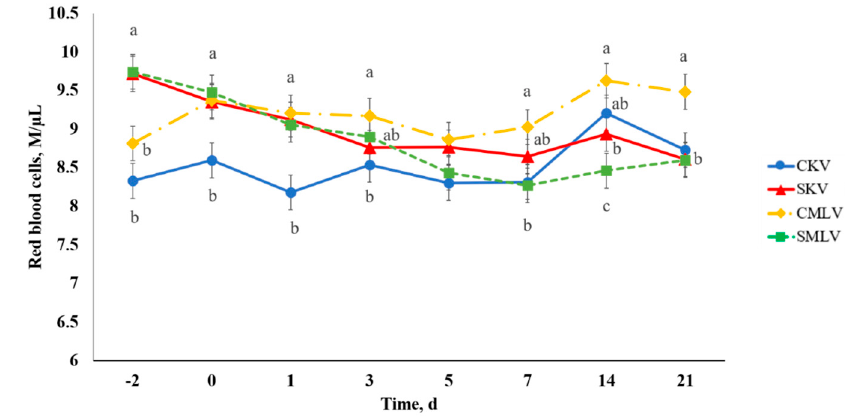
Figure 10. Effect of stress model and vaccination on red blood cells (RBC) after non-stress control (C; weaned on Day − 37; transported to West Texas A&M University research facility on Day − 21; vaccination on Day 0) and stress model implementation (S: weaned on Day − 3; transported to USDA-ARS Livestock Issues Research Unit on Day − 2; relocated to WTAMU on Day − 1; vaccination on Day 0) implementation and killed virus (KV; Triangle 5; Boehringer Ingelheim Animal Health, Inc. (BIAH)) and modified-live virus vaccination (MLV; Pyramid 5; BIAH) on Day 0. Red blood cells (stress model × vaccine treatment × day effect; p < 0.04). Across day, uncommon superscript letters between means indicate a difference ( p ≤ 0.05).